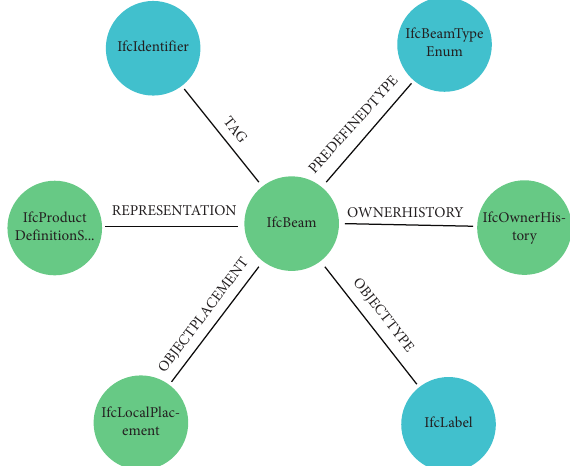
Figure 4: Graph data model for the IfcBeam